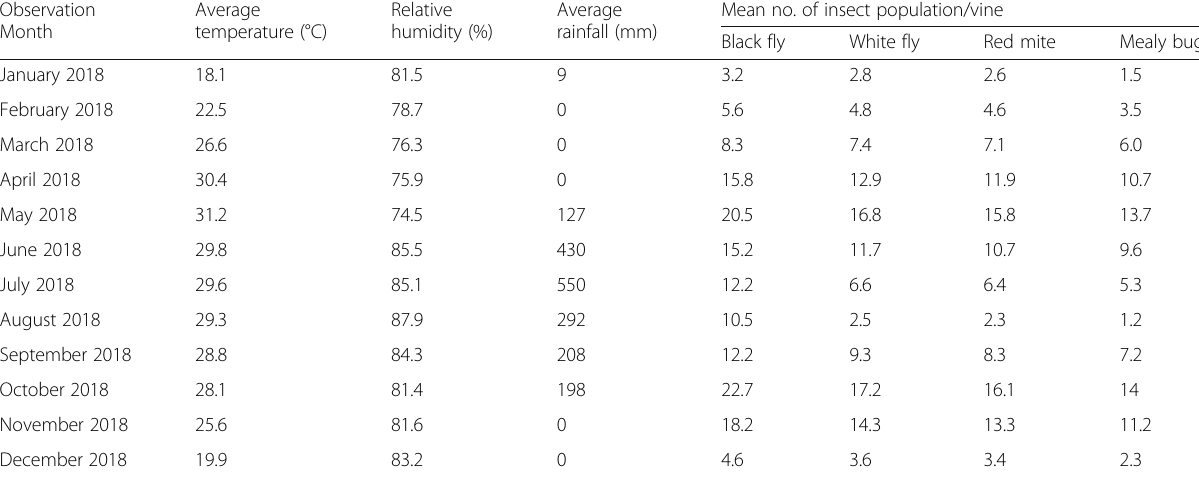
Table 1 Monthly distribution of meteorological parameters and insect population buildup in betel leaf during January to December 2018 Observation Average Relative Average Mean no. of insect population/vine Month temperature (°C) humidity (%) rainfall (mm) Black fly White fly